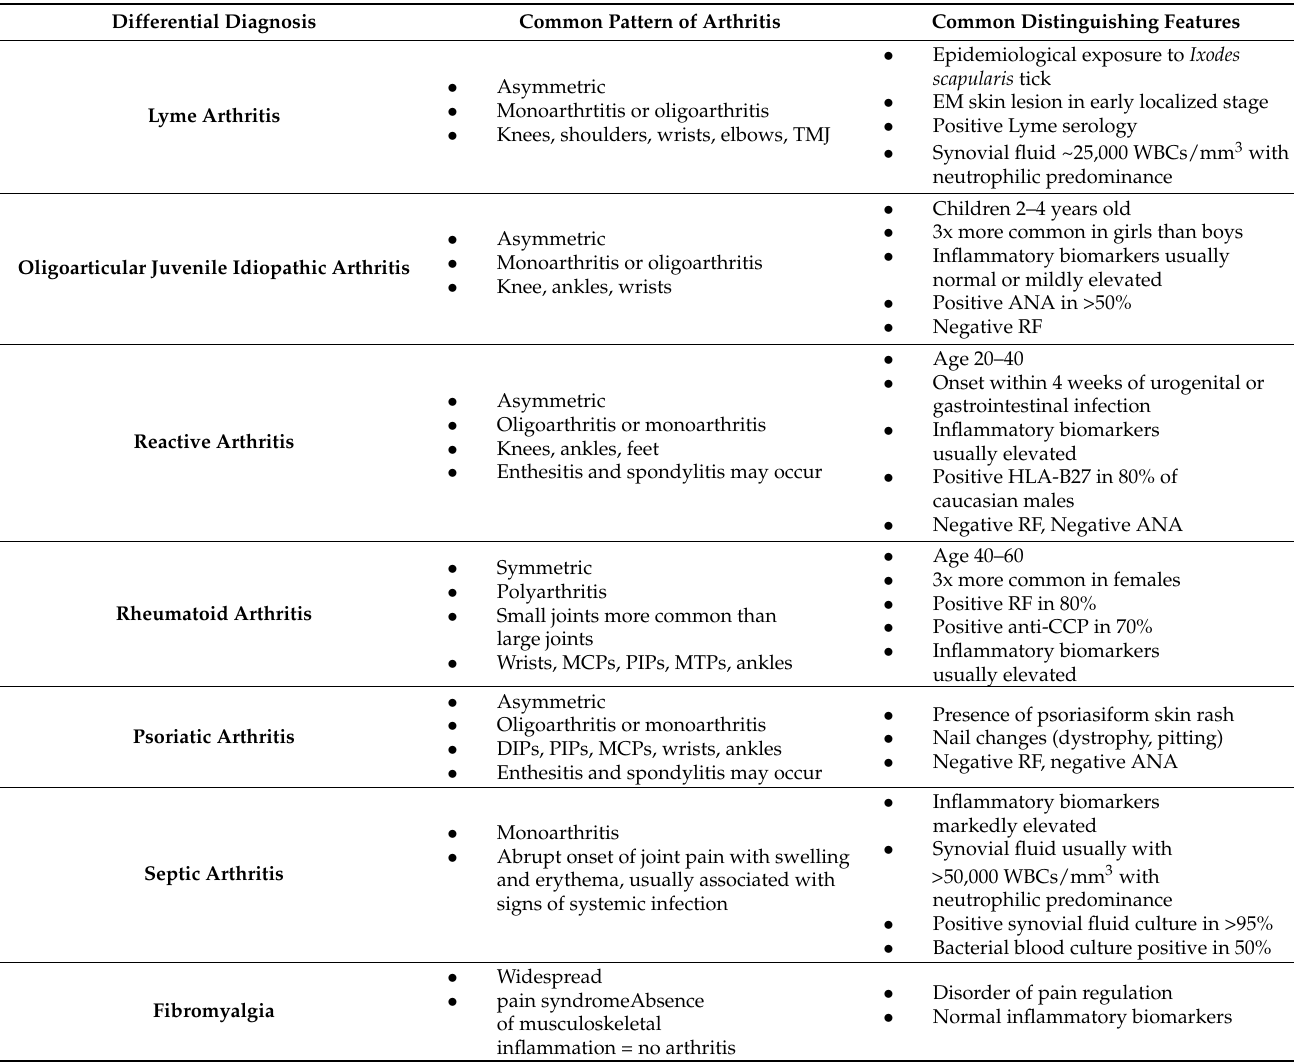
Table 1. Lyme arthritis and differential